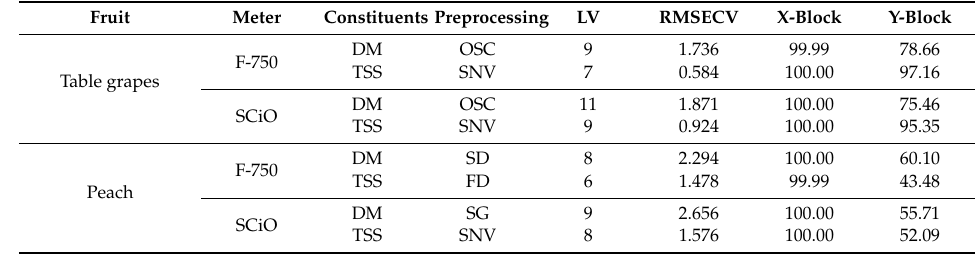
Figure 3. Number of latent variables (LV) versus root-mean square error of cross-validation (RMSECV) values in the partial least-squares regression (PLSR) calibration model to predict dry matter (DM) and total soluble solids (TSS) in table grapes and peach fruits using the F-750 and SCiO spectrometers. Circles indicate optimized number of LV for each model; when two circled points are present in a calibration model, blue dot circle indicates further adjustment to avoid over fitting. Table 4. Total percent variance of X and Y explained by the optimum number of latent variables (LV) captured by the regression model using